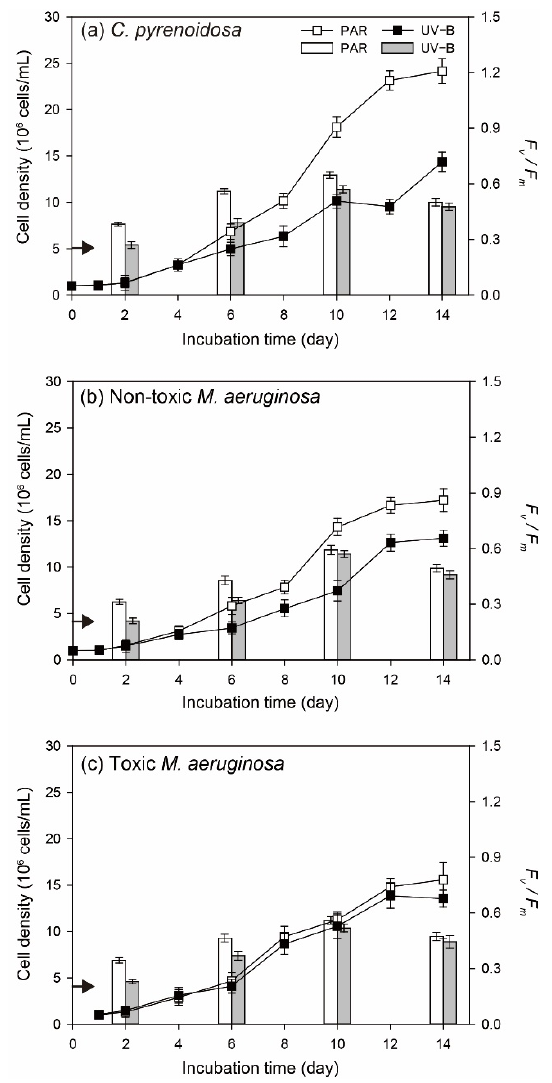
Figure 7. Cell density (line and scatter) and F v /F m (vertical bar) of three species in the PAR and UV-B treatments under nutrient enrichment conditions (the arrow indicates the initial value of F v /F m ).